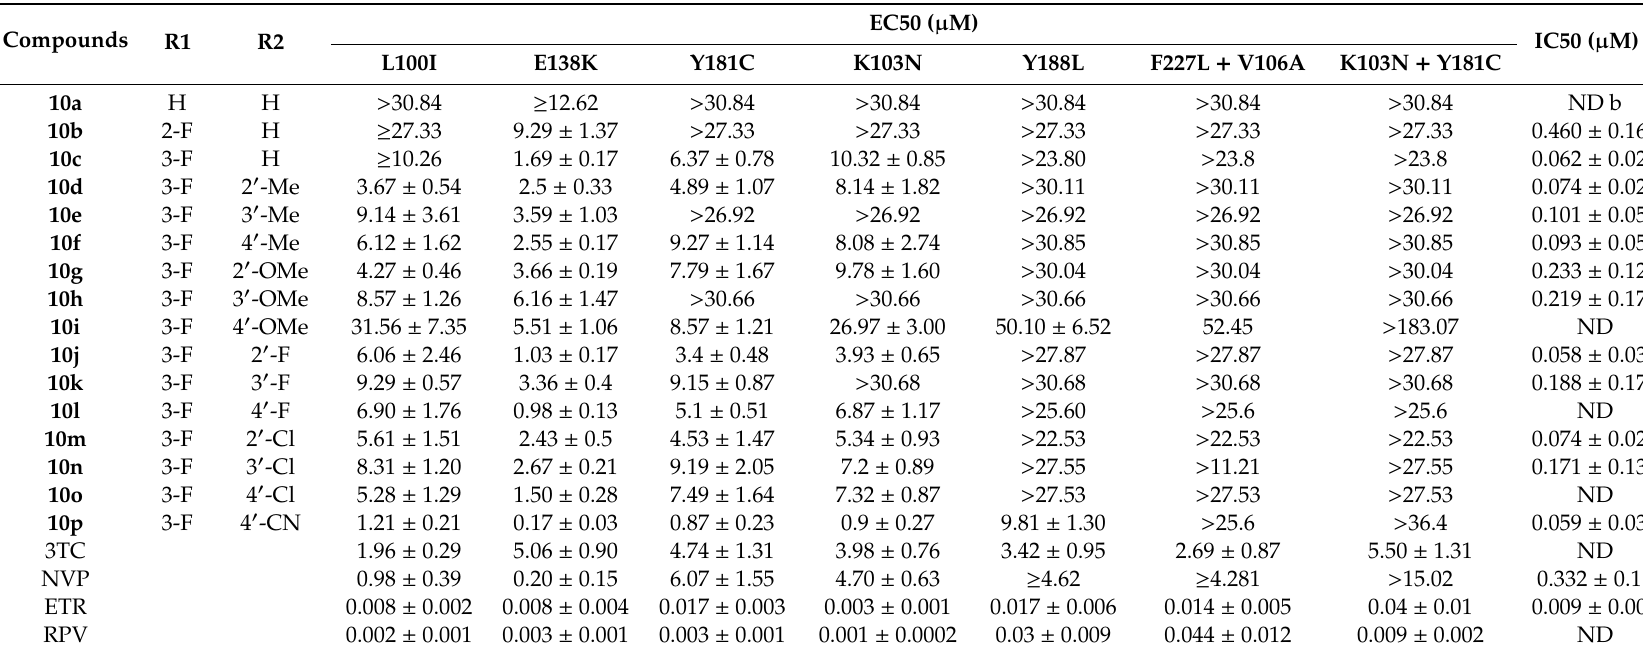
Table 2. The biological activity of the compounds 10a–p on the mutant HIV-1 virus strains and HIV-1 reverse transcriptase (RT) enzyme.